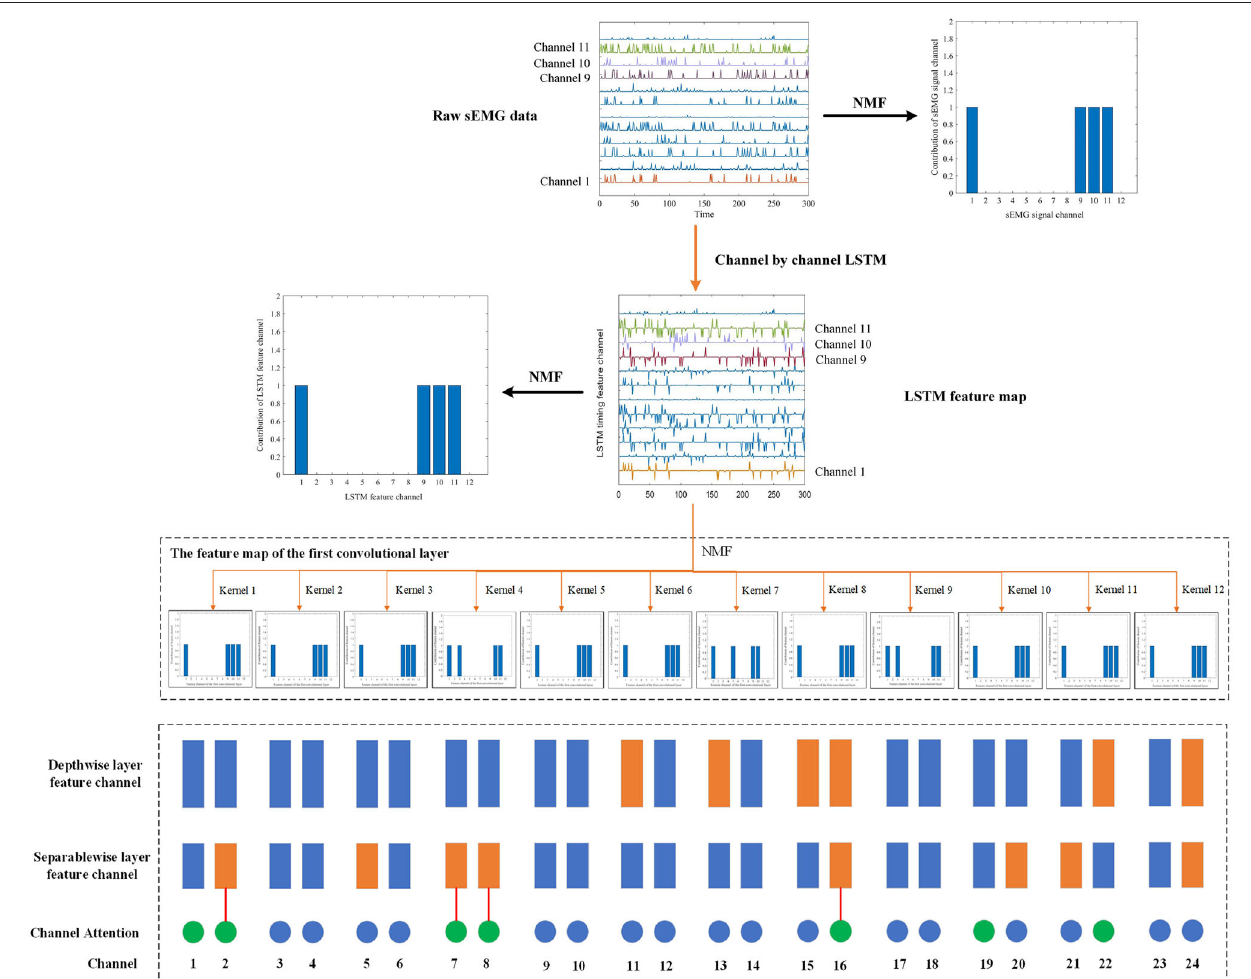
FIGURE 7 | We visualized the synergy characteristics flow of surface electromyography (sEMG) in the sitting movement of subject 7 in the within-subject situation. The figure shows the flow of synergy characteristics in different feature channels of the MCSNet model (orange lines and rectangles). The blue rectangles represent the feature channels of the depthwise and separablewise network layers. The circle represents the weight channel of the attention layer, and the green circle means the channel with a large weight. We found that the channel with a large attention layer weight is basically the same as the channel of the synergy characteristics flow direction. It can be considered that MCSNet can extract the synergy characteristics of the